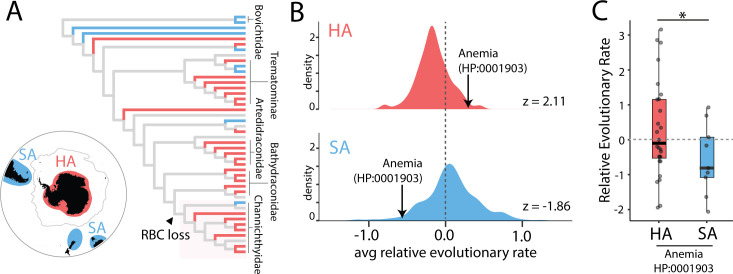
Elevated evolutionary rates in anemia-associated CNEs in high latitude notothenioids.(A) Notothenioid lineages designated as high-latitude Antarctic (HA) or sub-Antarctic (SA) as in Dornburg et al. 2017 [31]. (B) Distribution of average relative evolutionary rates across CNEs in all extant branches for each Human Phenotype Ontology term associated with at least 1000 CNEs. (C) Relative evolutionary rates of extant lineages. The asterisk indicates one-tailed t-test p-value < 0.05.